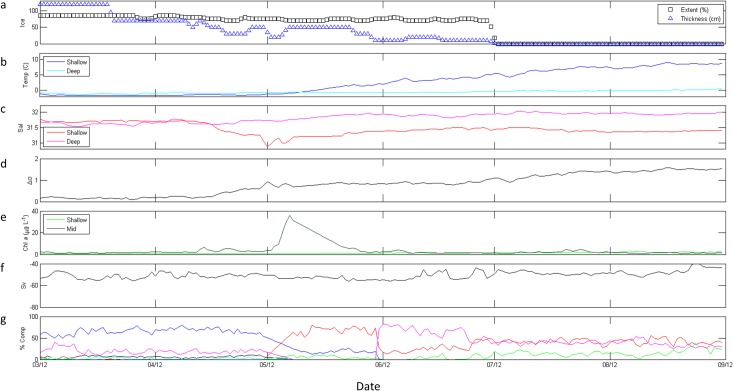
M2 data from March through August 2012.(a) ice extent (%, black boxes) and thickness (blue triangles); (b) shallow (dark blue) and deep (cyan) temperature (° C); (c) shallow (red) and deep (magenta) salinity; (d) stratification (Δσ); (e) shallow (light green) and mid-column (dark green) Chl a fluorescence (μg L-1); (f) total scattering volume (Sv); (g) percent composition of classes of scatterers, including SmCrust (black), MdCrust (blue), LgCrust (red), WkReson (green), StReson (cyan), and Unclass (magenta). Note the different scale for Chl a (e), with a maximum of 40 μg L-1.